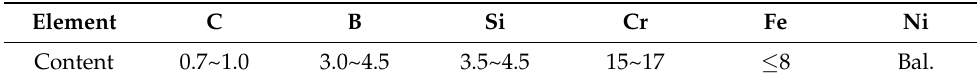
Table 2. Chemical composition of the Ni60 alloy